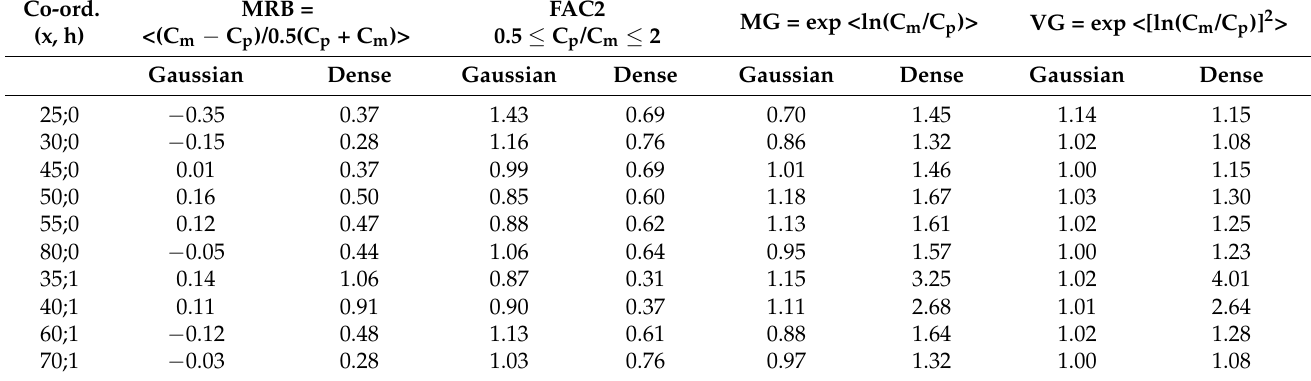
Table 4. Statistical performance measures (SPMs) of the maximum determined theoretical values (C p ) for the dense gas model and Gaussian gas model relative to the maximum recorded gas concentration (C m ) for measurement series 2. Designations: MRB—mean relative bias; FAC2—the fraction of predictions within a factor of two of the measurements; MG—geometric mean bias; VG—geometric variance; red colour—values obtained outside the range of model compliance with the experiment.